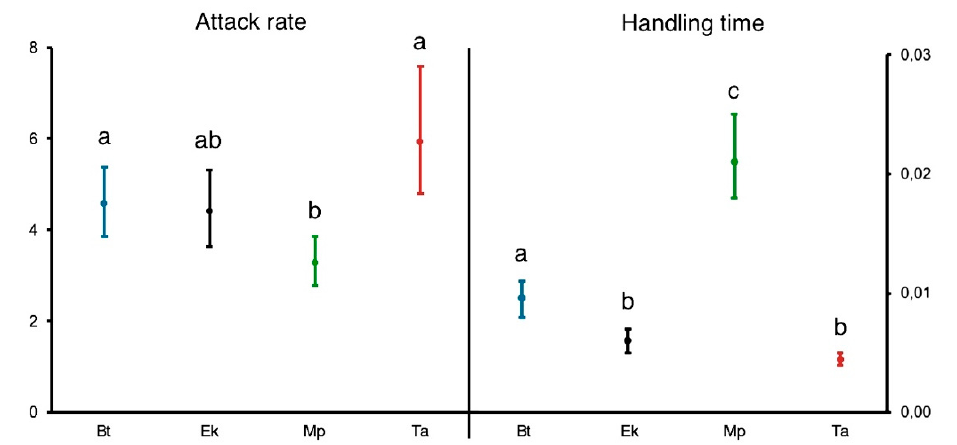
Figure 3. Estimates of functional response parameters attack rate, and handling time for Dicyphus cerastii females feeding on Bemisia tabaci 4th instar nymphs (Bt), Ephestia kuehniella eggs (Ek), Myzus persicae 1st instar nymphs (Mp) and Tuta absoluta eggs (Ta). Error bars represent bootstrapped 95% confidence intervals (CIs). In each parameter, overlapping 95% CIs are represented with the same letter. Note the different vertical axis scale.